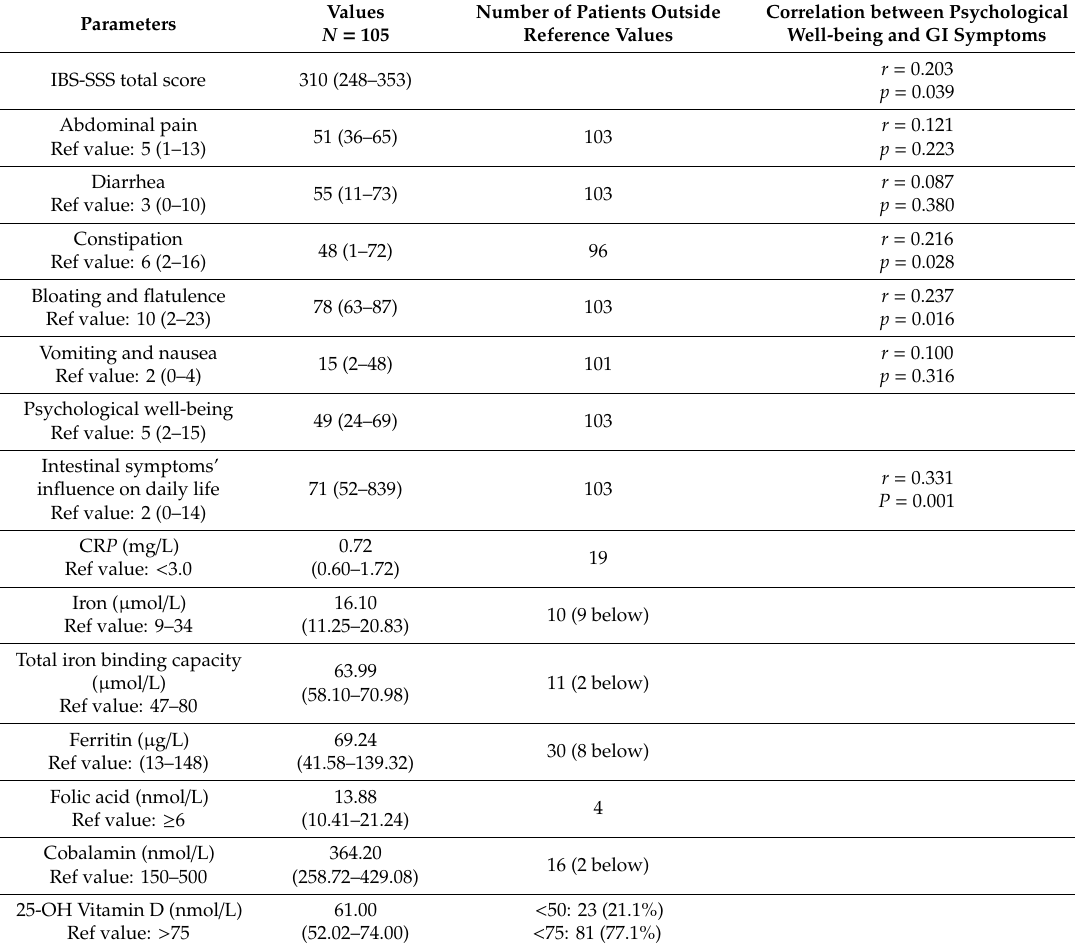
Table 2. Values of gastrointestinal symptoms and blood samples at